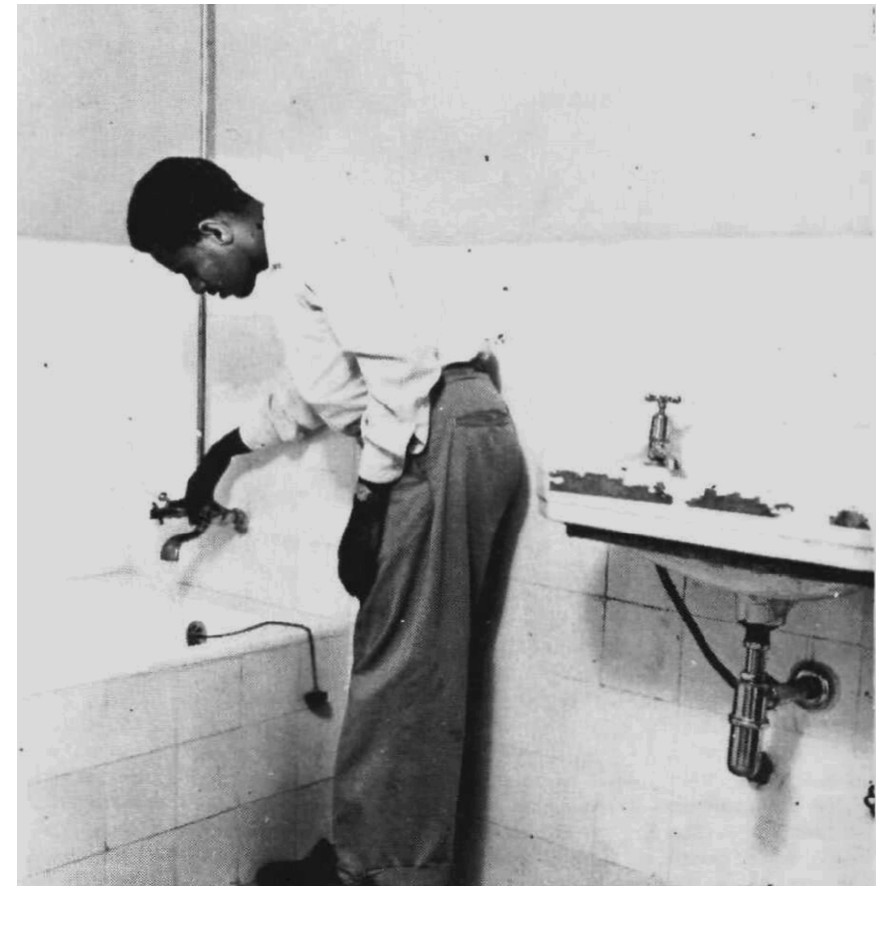
A resident checking bath fix - tures in his new house in 1958. Source: Saudi